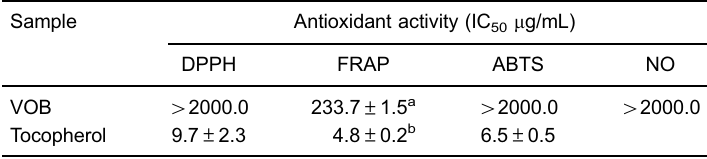
Table 2. Antioxidant activity of vegetable oil blend (VOB) determined by the chemical tests DPPH, ABTS, FRAP, and NO radical scavenging assay. Sample